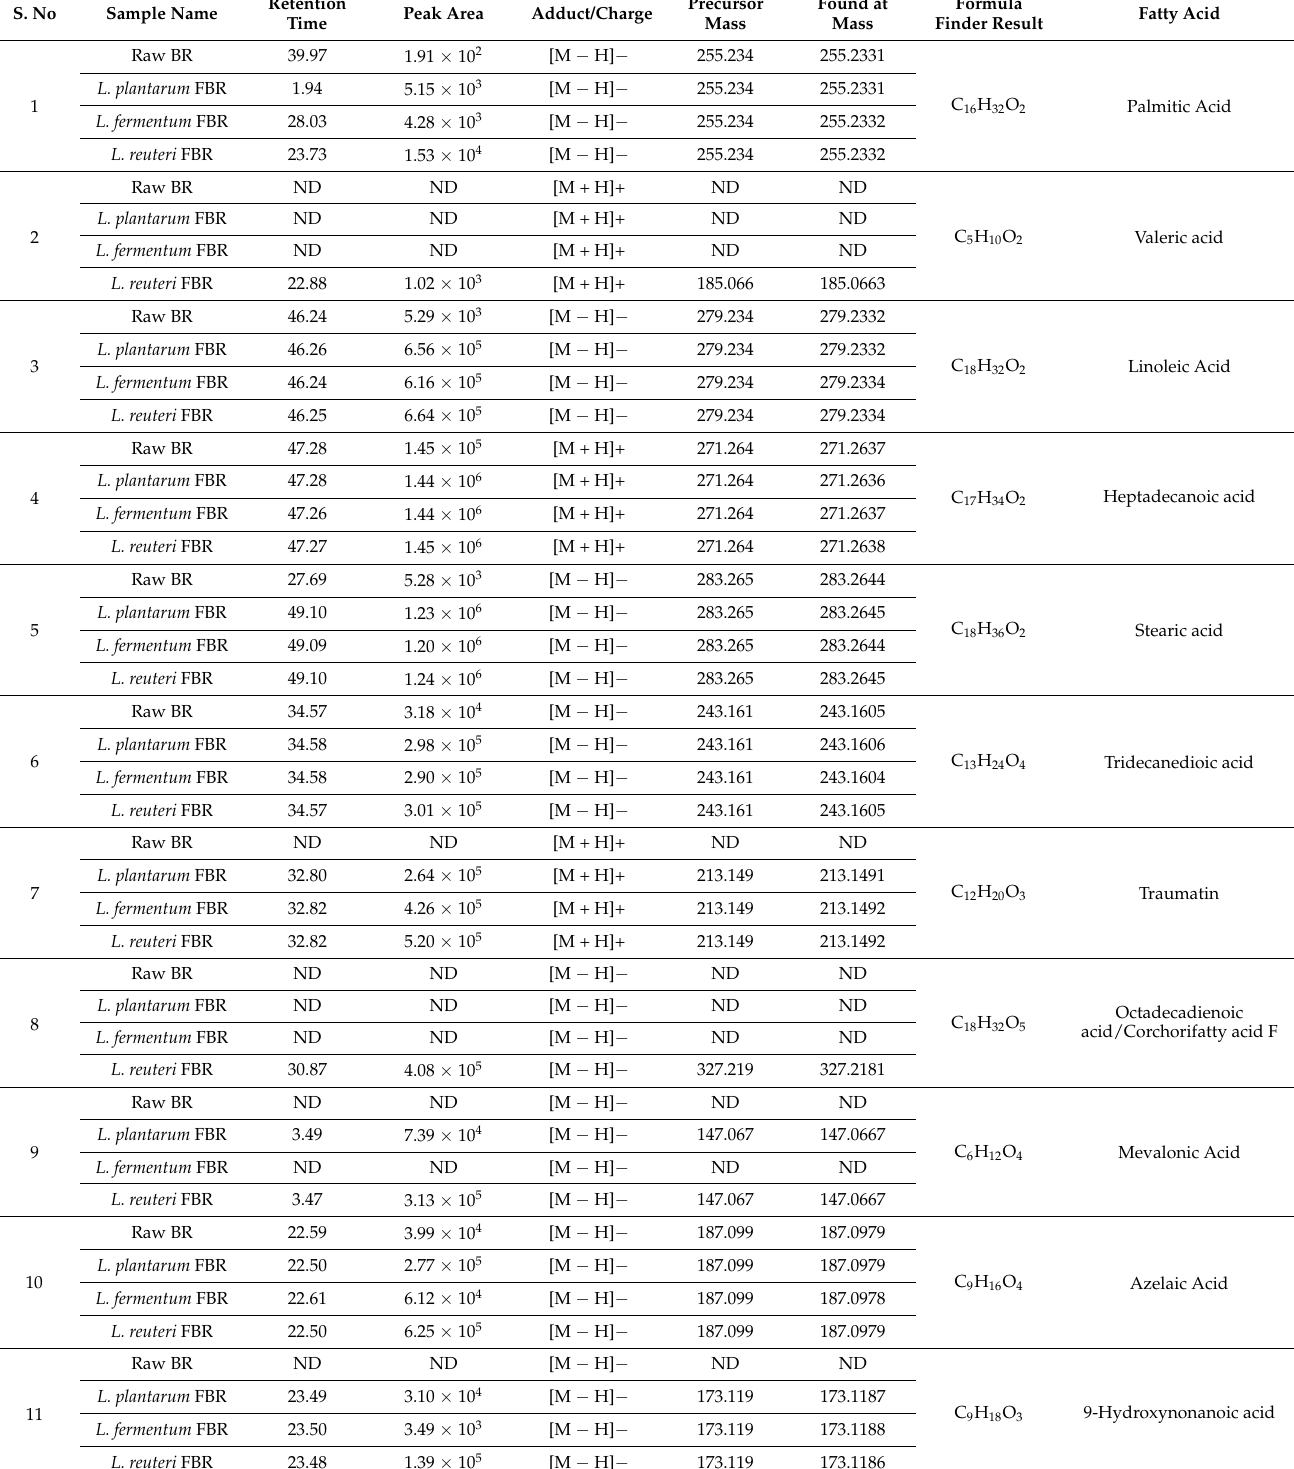
Table 4. Fatty acids detected in raw and LABs fermented brown